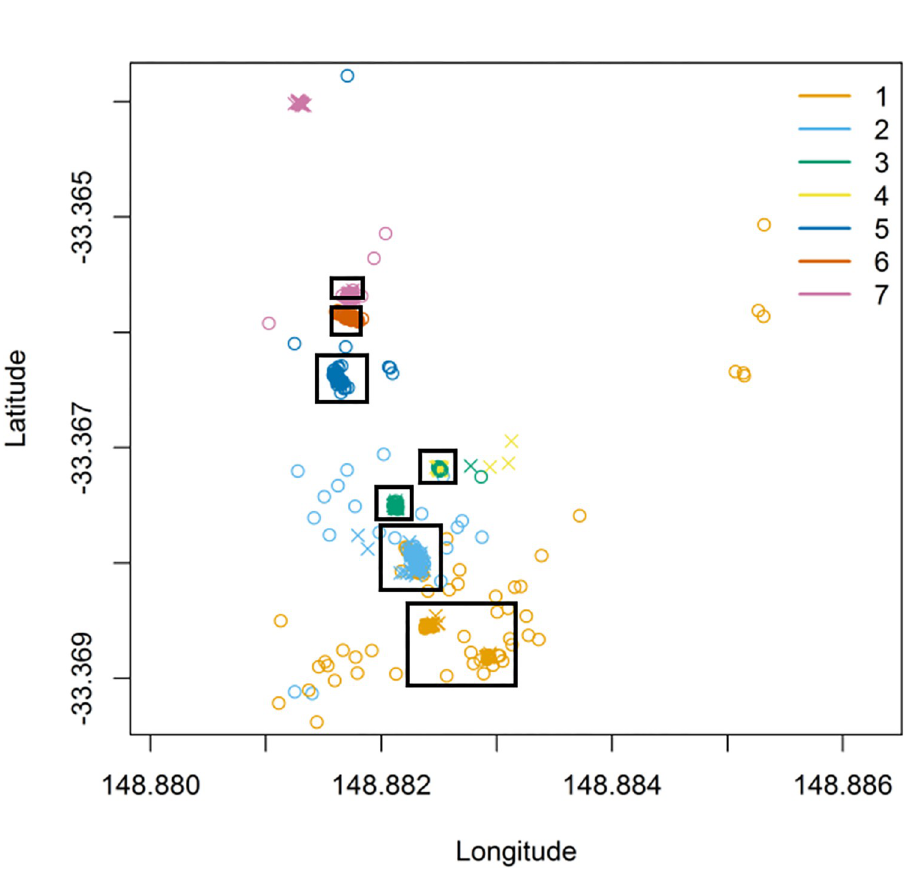
Fig 7. Detections of each logger using a hand-held Yagi antenna and receiver throughout the study. Detections occurred at 05:30, 16:00 and randomly between 22:00–02:00, Monday–Friday. Colours indicate the warren of capture (n = 7). Black squares indicate estimated warren extent. Circles represent juveniles and crosses represent adults. Axes are scaled to equal distance.